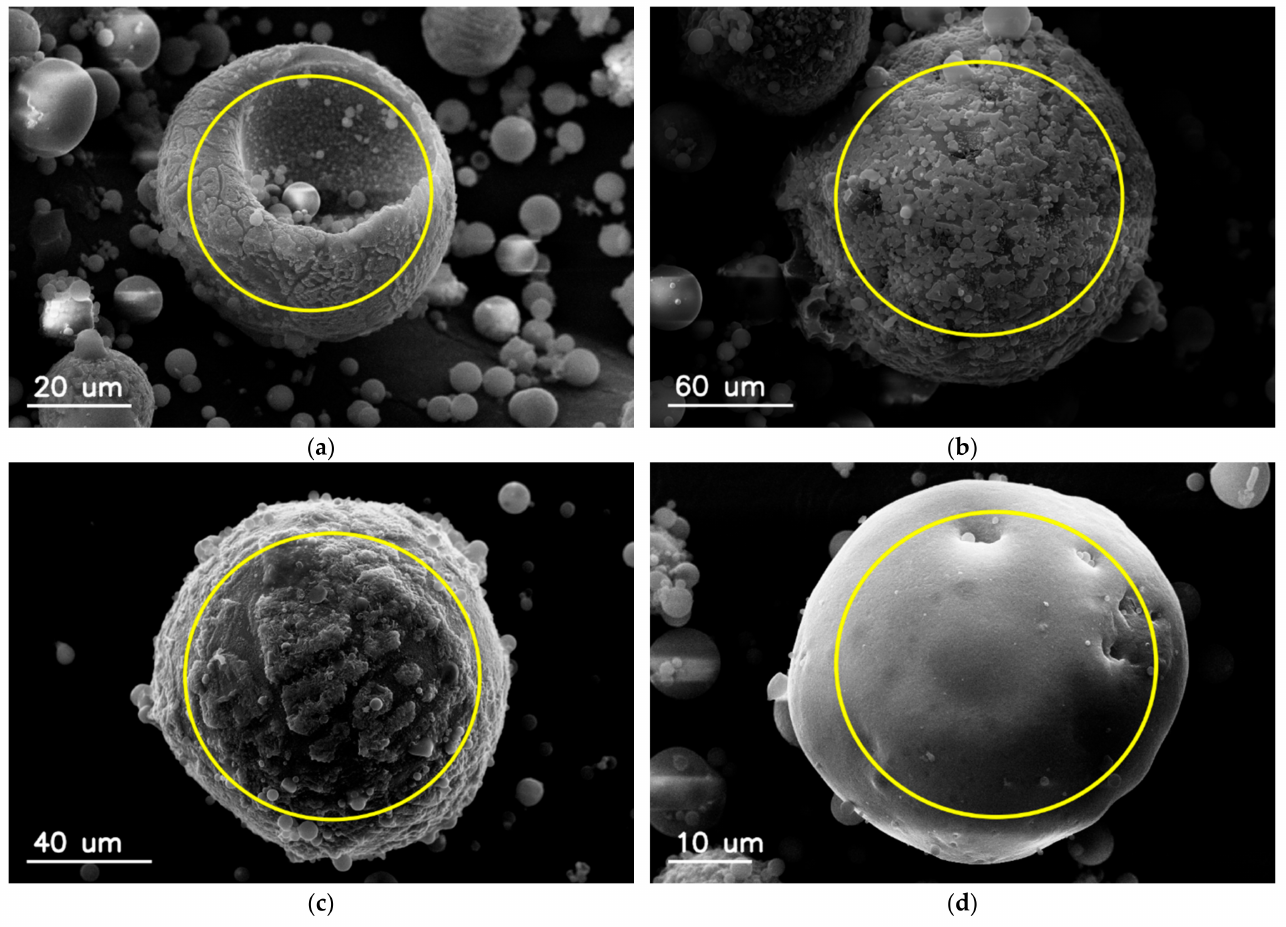
Figure 3. SEM images of individual magnetic particles recovered from fly ash and the corresponding iron content: ( a ) 51.15; ( b ) 29.08; ( c ) 16.30; ( d ) 2.02 (in wt.%). The scanning area of electron beam for EDS measurements is marked with a circle in each